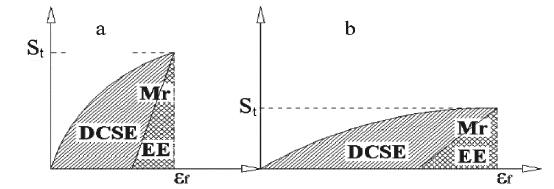
Fig. 12. Schematic of two stress-strain curves for: a) hard material; b) soft material